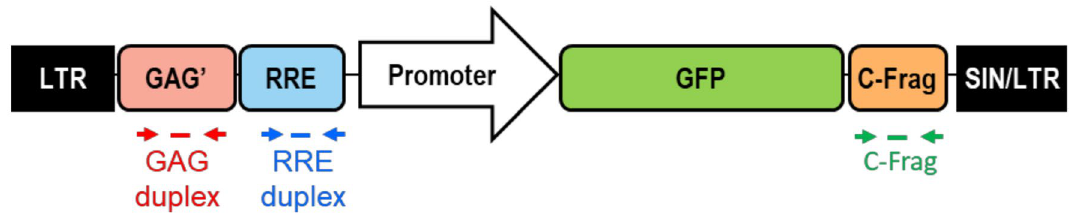
Figure 1. Schematic diagram of lentiviral vector used for development of Jurkat cell based VCN reference standards. Third generation lentiviral vector encoding green fluorescent protein (GFP) under the control of the human elongation factor 1 alpha (EF1α) promoter was used for stable transduction of Jurkat cells to engineer VCN reference standard cell lines. Selected single cell clones were characterized using three independent qPCR assays with primers and probe sets targeting three distinct sequences in the integrated lentiviral provirus DNA: GAG’, RRE and C-Frag Id tag. Additionally, RRE duplex primers and probes were used for ddPCR assay to evaluate performance of qPCR-based VCN assays and to measure vector copy number by an independent molecular